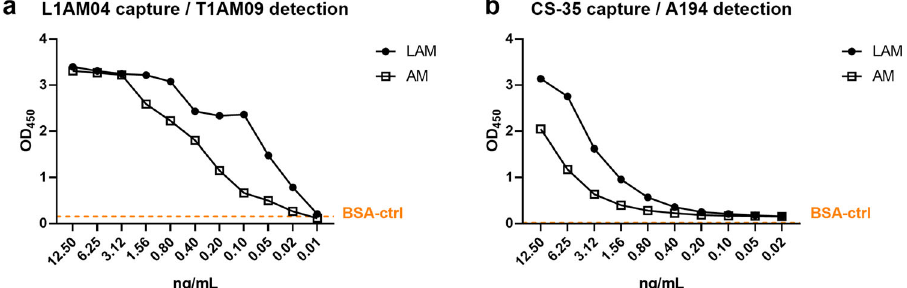
Fig. 5 Combination of high-af fi nity human mAbs to distinct AM epitopes can detect low levels of LAM and AM in urine by sandwich ELISA. Detection of serial dilutions of LAM and AM generated from the clinical Mtb strain CDC1551 and spiked into urine of a healthy volunteer by a L1AM04 (10 µ g/mL) as a capture and T1AM09 (250 ng/mL) as a detection mAb, and b murine mAb CS-35 (10 µ g/mL) as a capture and human mAb A194 (250 ng/mL) as a reference. The data shown are representative from two separate experiments.